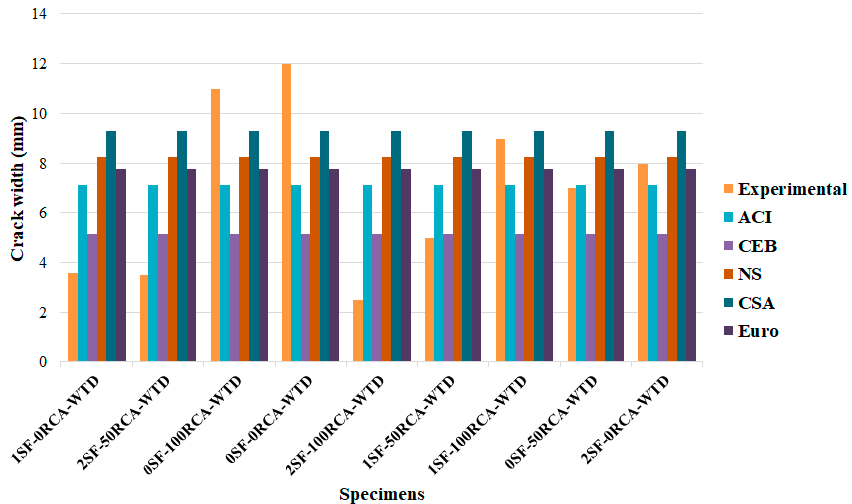
Figure 22. Observed versus predicted ultimate crack width of specimens without shear rebars.